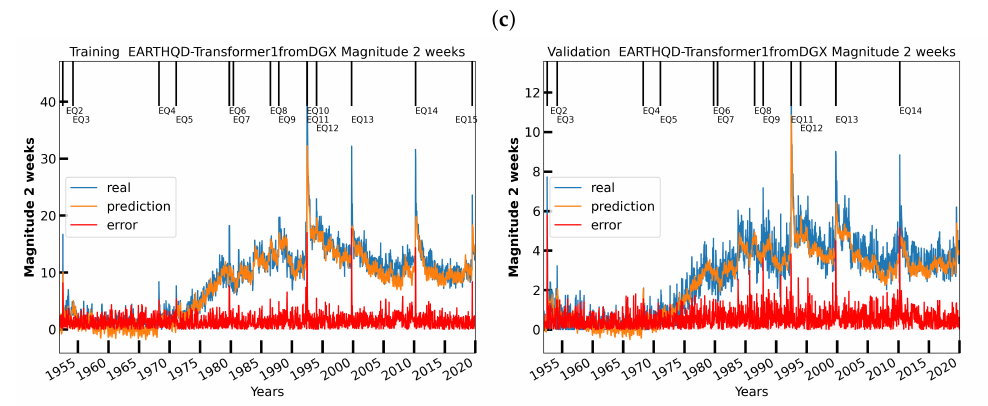
Figure 16. Two-week m bin ( F : ∆ t , t ) results for ∆ t = 2 weeks (training on left, validation on the right) are given for 3 methods. The earthquakes marked are listed in Table 1. ( a ) Two-week LSTM results for m bin ( F : ∆ t , t ) for ∆ t = 2 weeks. ( b ) Two-week TFT results for m bin ( F : ∆ t , t ) for ∆ t = 2 weeks.